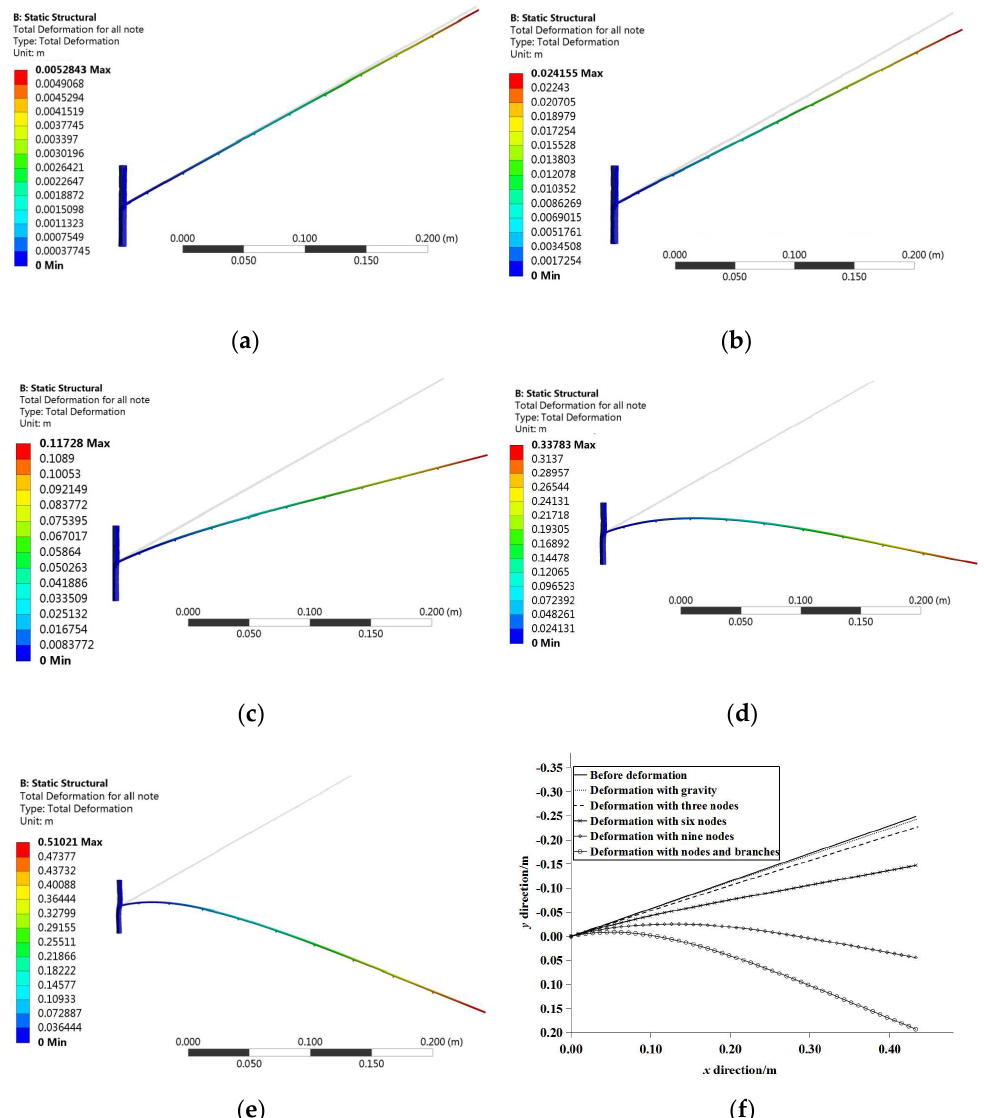
Figure 7. Deformation of fruit-bearing branches under different loads: ( a ) deformation under only branch gravity; ( b ) deformation under the action of the first three nodes; ( c ) deformation under the action of six nodes; ( d ) deformation when all nodes are loaded; ( e ) deformation with two branches; ( f ) comparison of centerline under each load deformation.